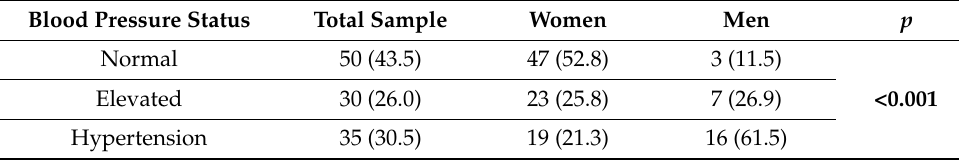
Table 2. Prevalence of blood pressure status according to sex.